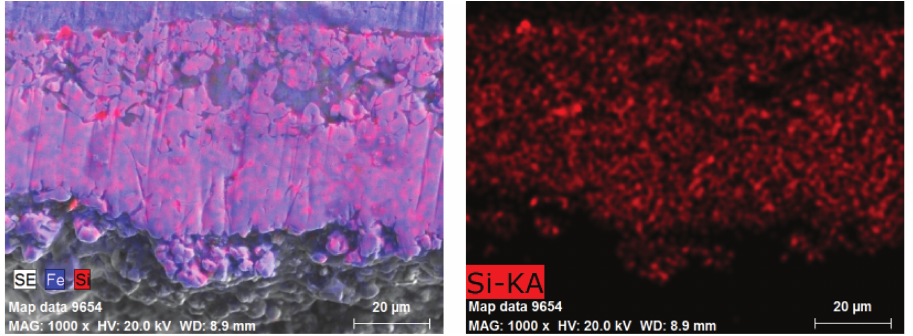
Figure 10: EDS mapping result of the silicon steel sample after deposition.